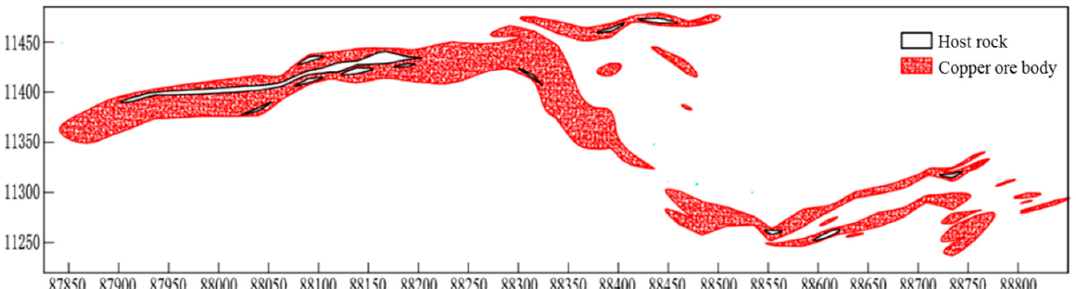
Figure 5. Geological ore body distribution in the 1450–1570 stage of Huogeqi Copper Mine under the Xian-80 coordinate system.